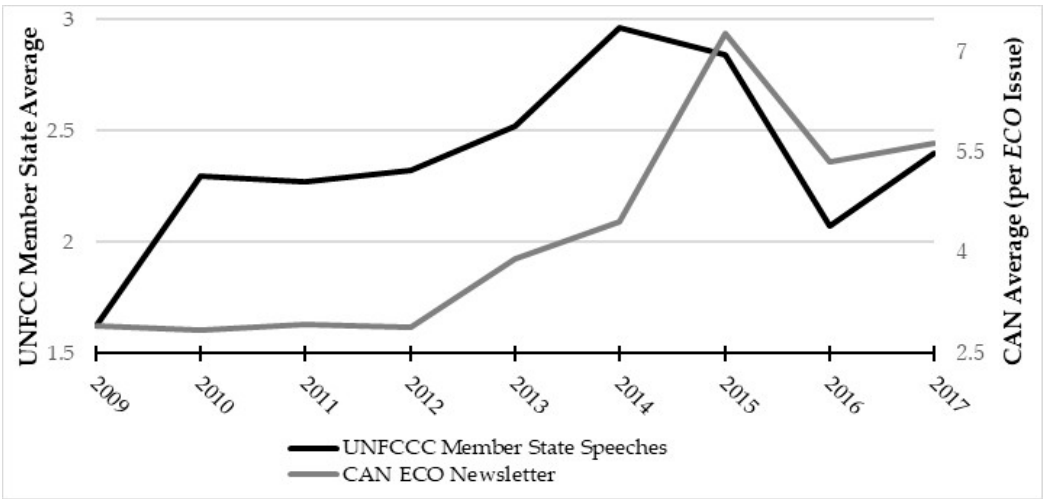
Figure 5. Average Climate Justice Mentions by UNFCCC Member States and CAN. 18